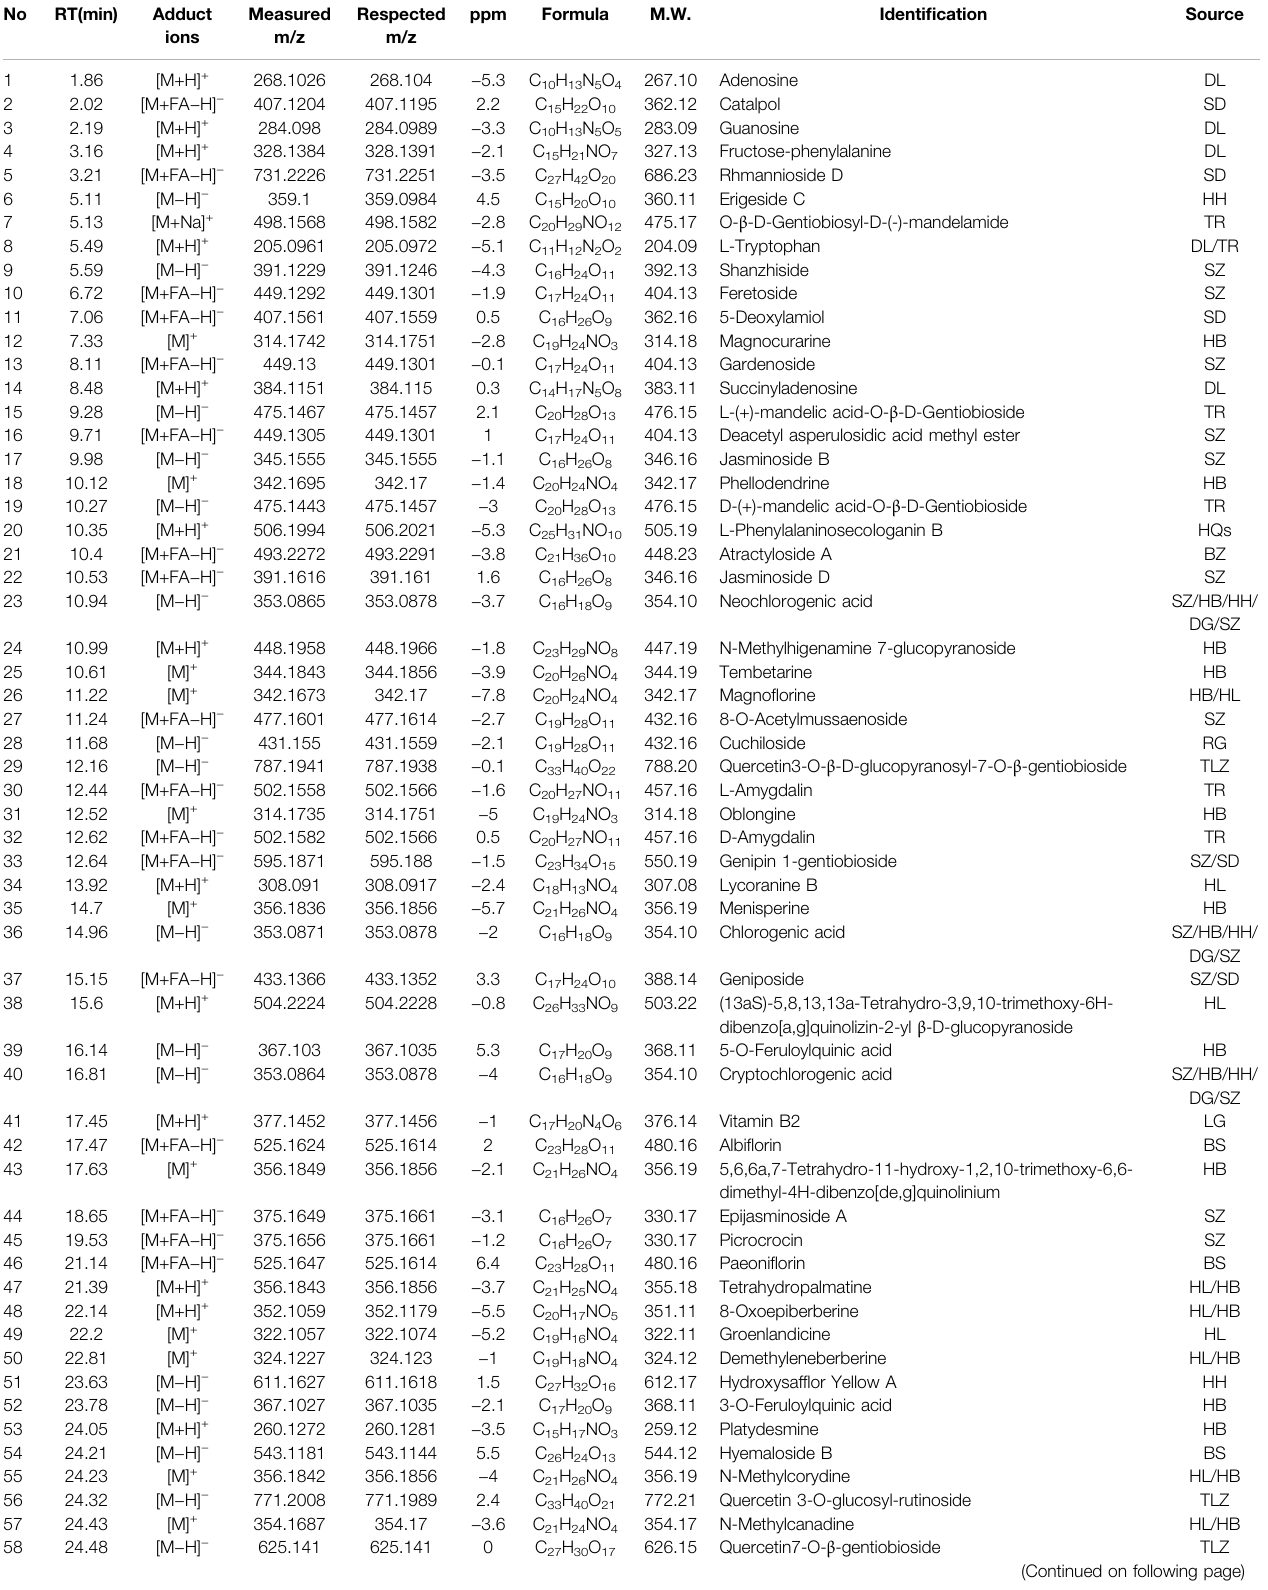
TABLE 1 | Identi fi cation of the major chemical compounds in